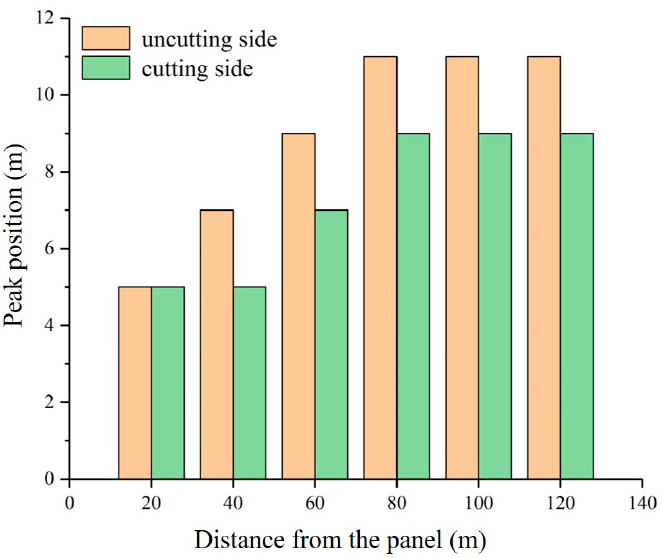
Figure 14. Variation curve of lateral abutment peak position.